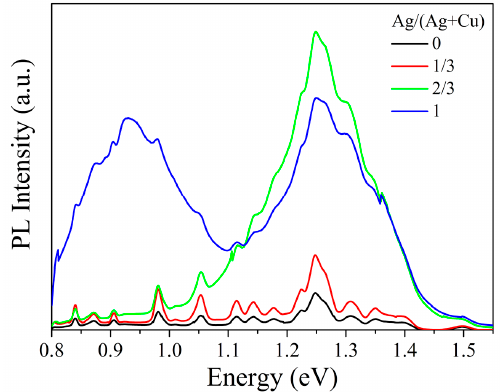
Figure 8. Photoluminescence spectra of Mn single-doped and Ag and Mn co-doped Cu 2 ZnSnS 4 thin films with different Ag/(Ag + Cu) ratios.